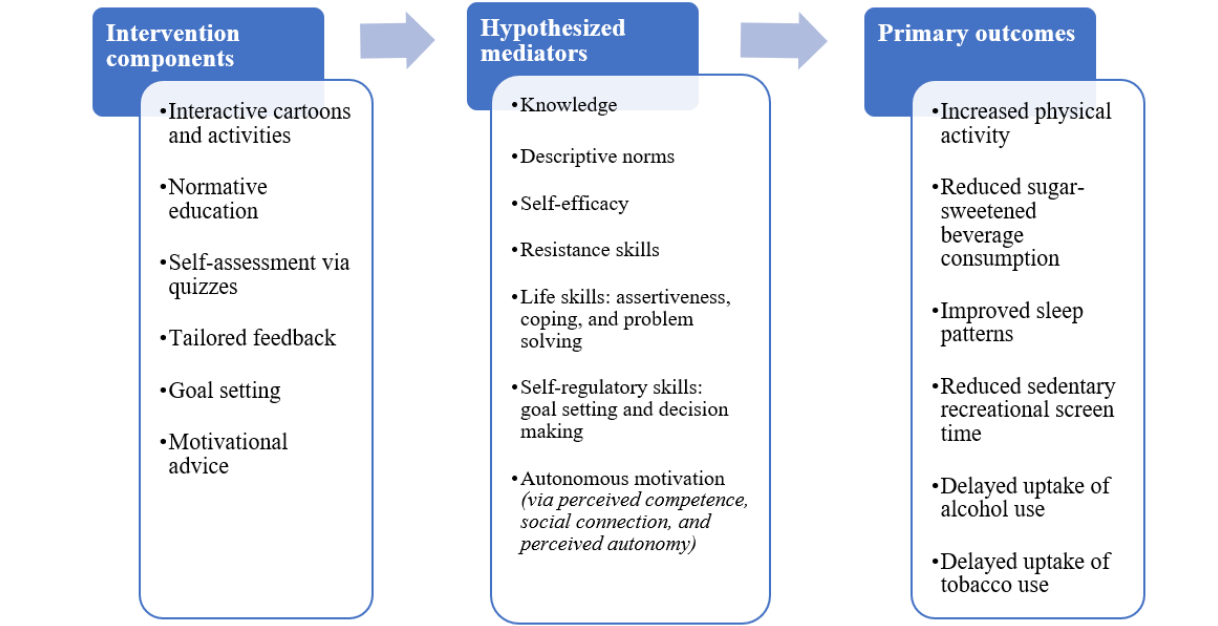
Figure 2. Health4Life Conceptual